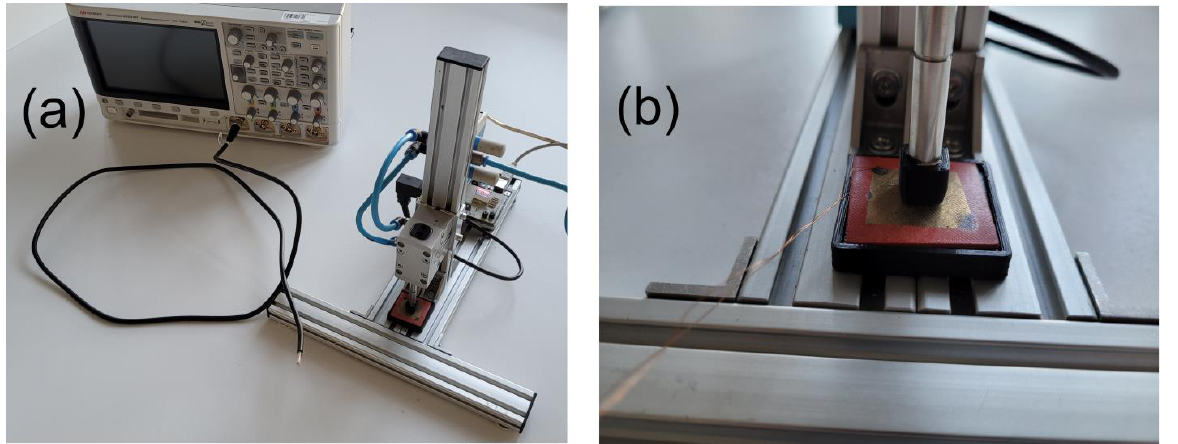
Figure 1. The stages of sample preparation: ( a ) mixing of PU resin and SbSI nanowires, ( b ) mixture degassing, ( c ) casting into the mold, ( d ) extraction of the cured sample from the mold, ( e ) deposition of gold electrodes, and ( f ) attachment of the copper wires.